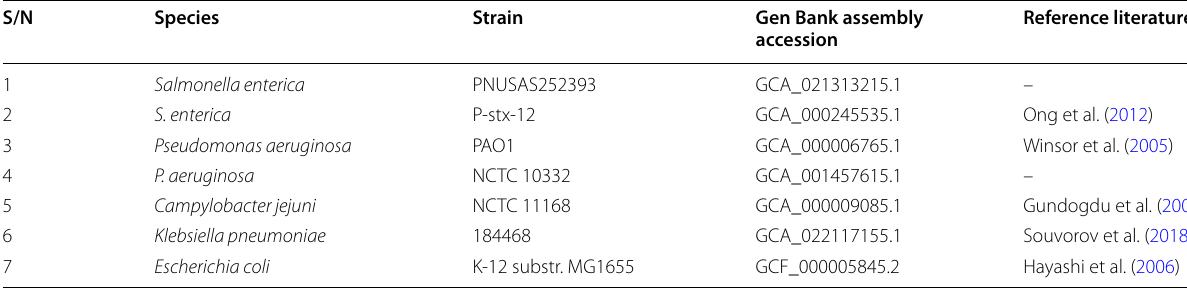
Table 1 Specification of bacterial strains used for the